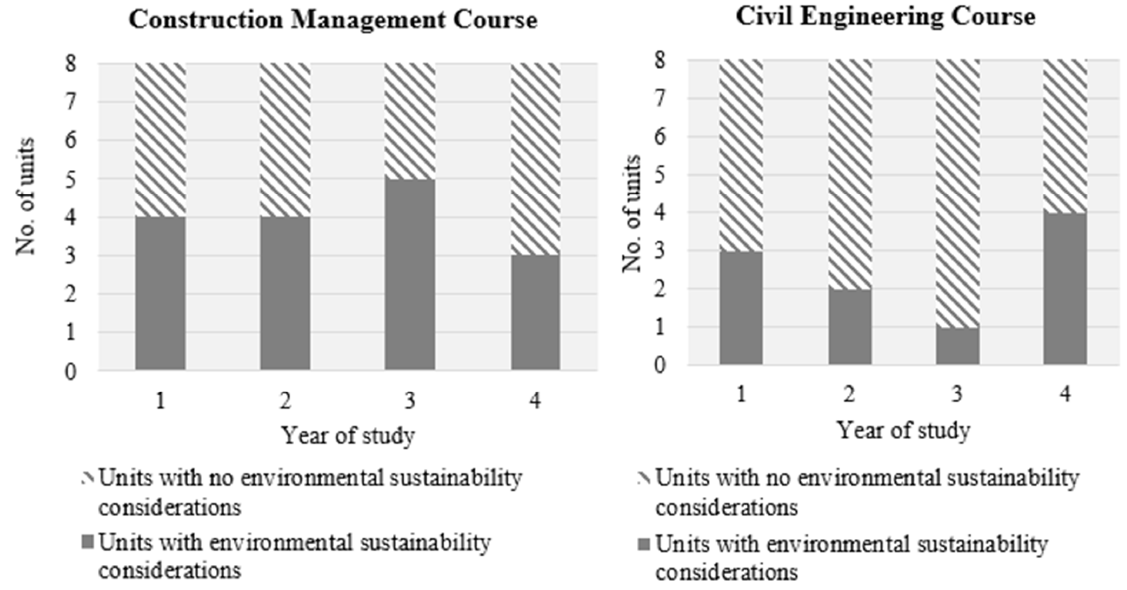
Figure 7. Distribution of environmental sustainability units by year of study .